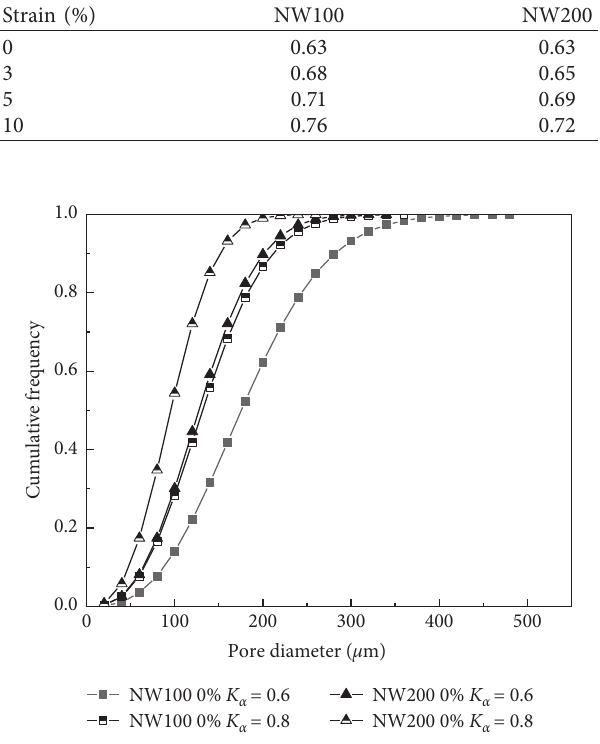
Figure 6: Parametric study of K